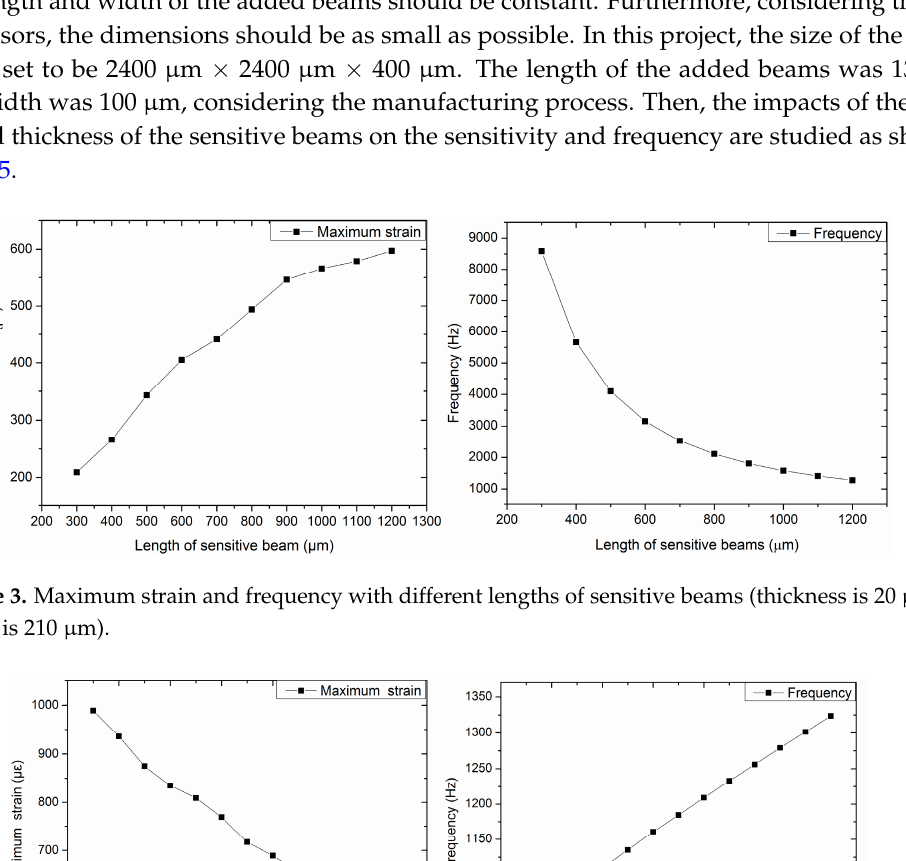
Figure 3. Maximum strain and frequency with different lengths of sensitive beams (thickness is 20 μ m; width is 210 μ m).